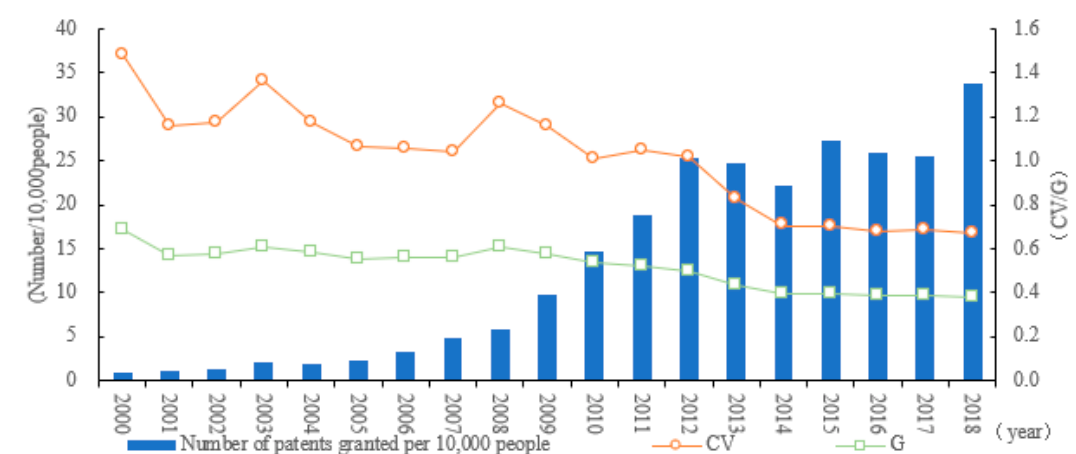
Figure 3. Overall evolution of innovation in the YRD from 2000 to 2018.